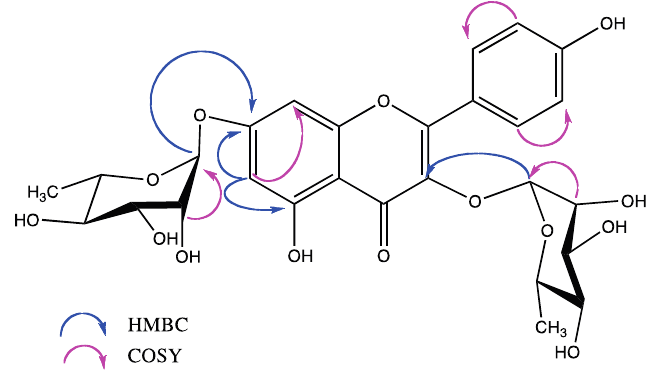
Figure 1. Structure and key COSY and HMBC correlations observed for